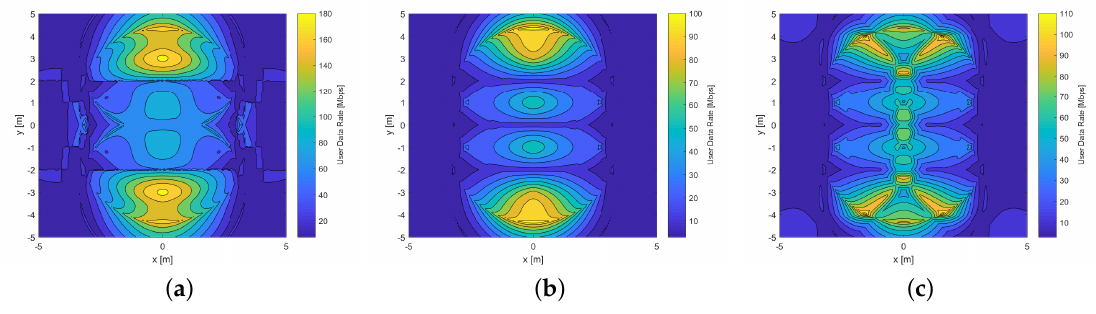
Figure 10. UDR distribution of the pyramidal ADR in the mining roadway scenario: ( a ) MRC scheme, ( b ) EGC scheme, and ( c ) SBC scheme.